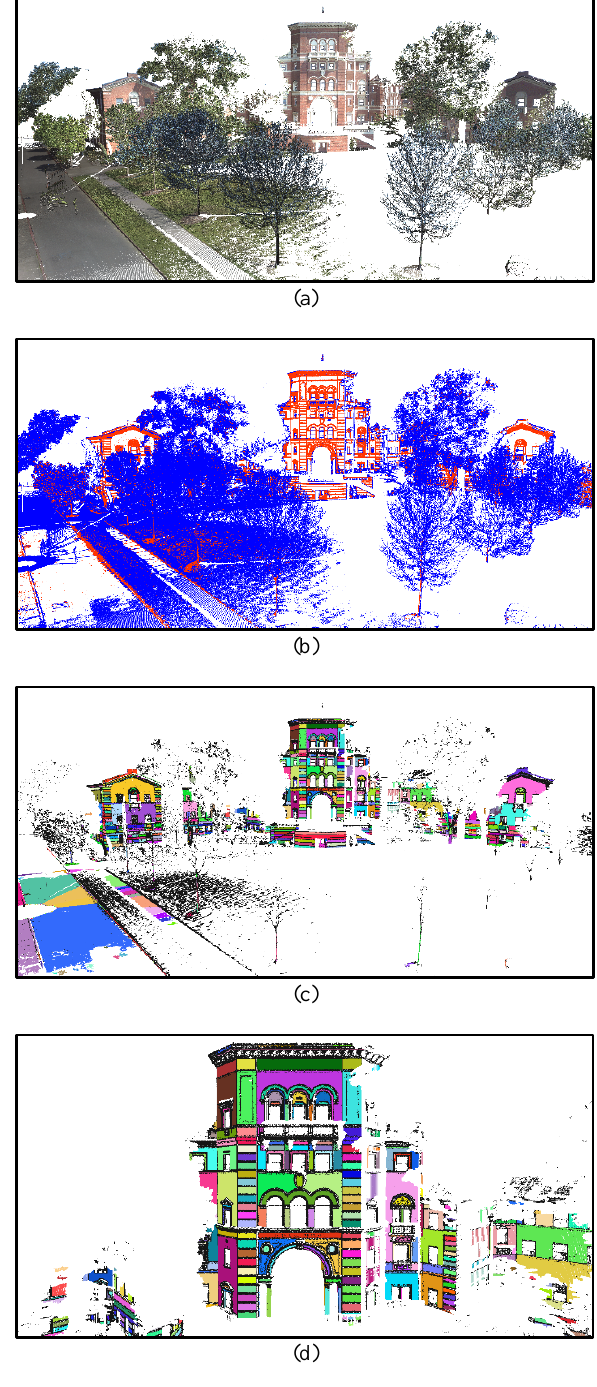
Figure 6. Segmentation results for an outdoor scan: (a) the raw TLS data colored by image texture; (b) the edge detection where extracted silhouettes are colored in blue while the edges are in orange; (c) grouping of smooth surfaces following region growing where the borders of each segment are colored in black and each segment is randomly colored; (d) close-up view of the segmentation result for the building